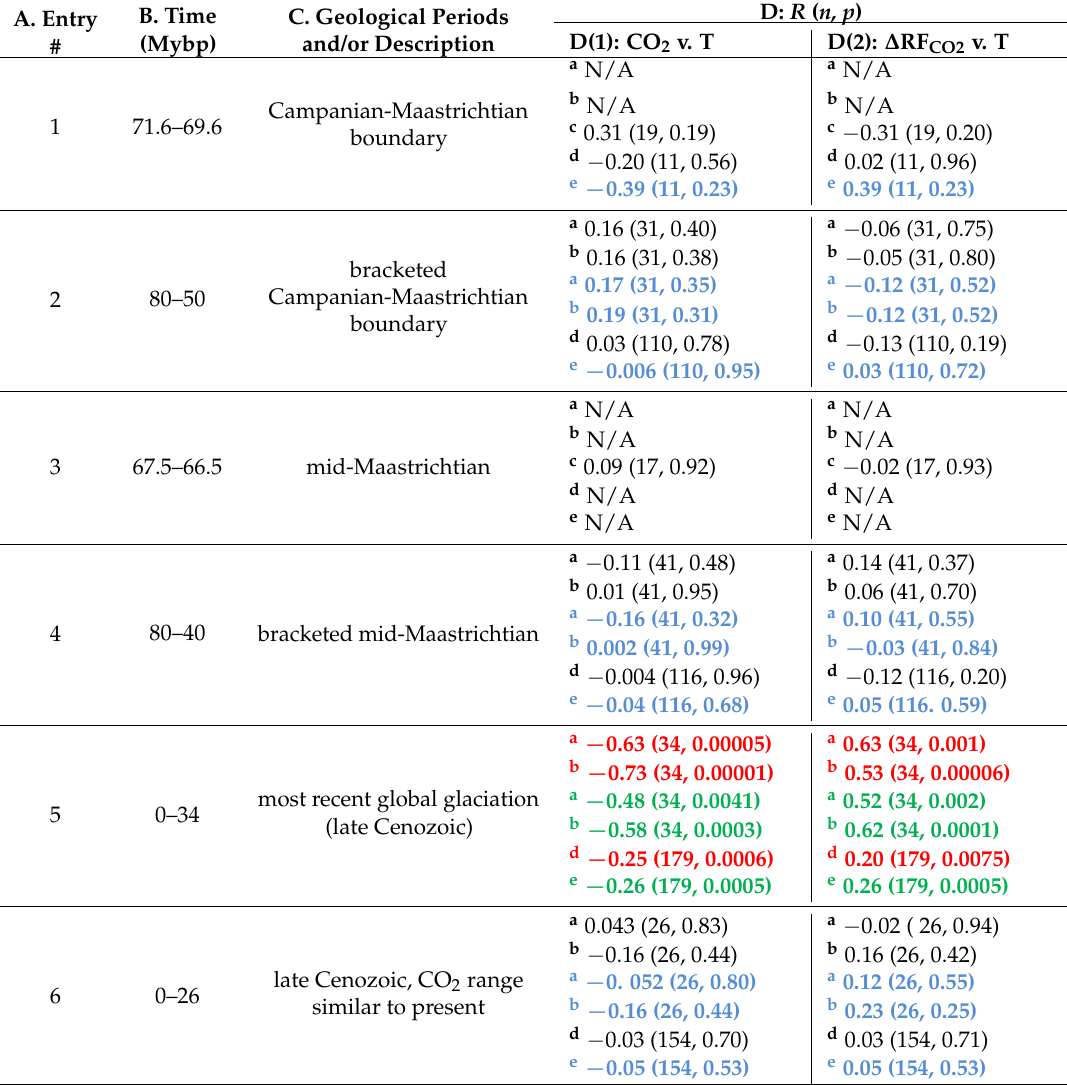
Table 1. Correlation coefficients, temperature vs. atmospheric CO 2 concentration (column D1) and temperature vs. marginal forcing (column D2) for the most recent (highest resolution) time periods of the Phanerozoic